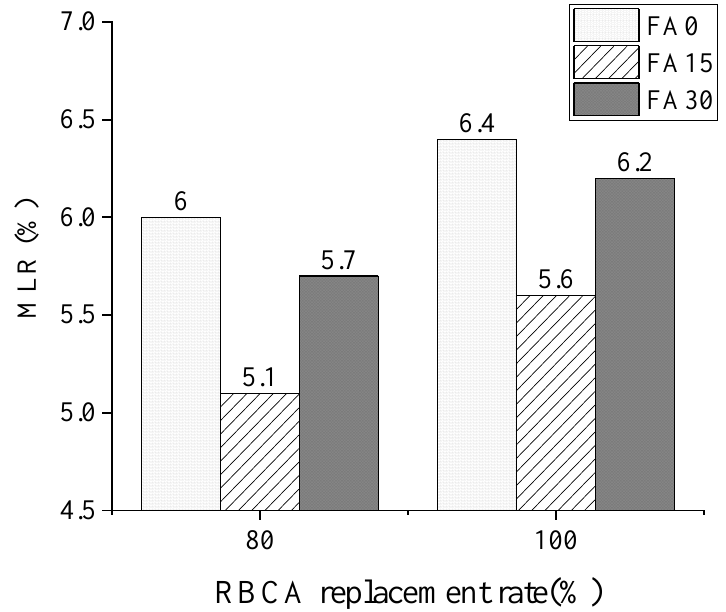
Figure 7. Multifactor influence on the mass loss rate of 3%NS-45FT.